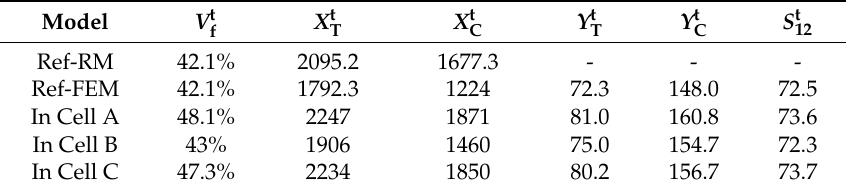
Table 5. Strength of composite tows obtained using micromechanical model/MPa.